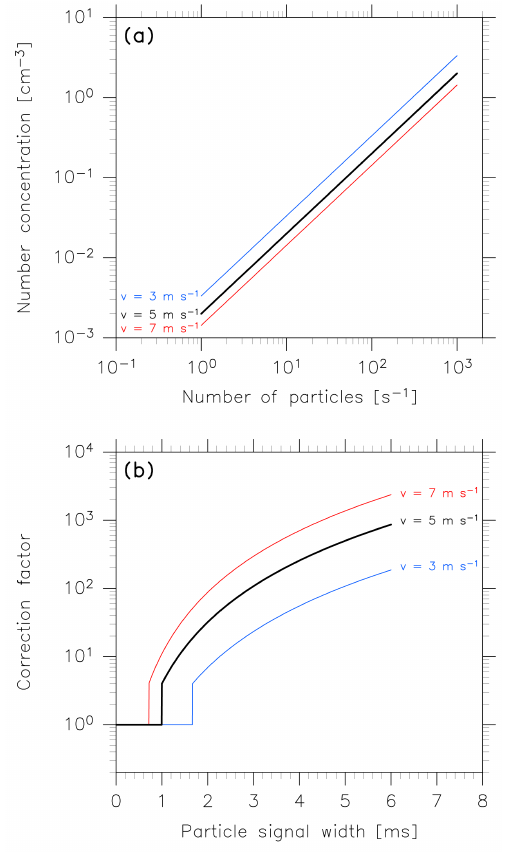
Figure C1. Dependence on the flow speed within the detection area ( v in ms − 1 ) for (a) the conversion from number of particles in s − 1 to number concentration in cm − 3 and (b) the correction factor for the number of particles ( N in s − 1 ) with respect to the particle signal width values in ms. Shown are for 5ms − 1 (black), 3ms − 1 (blue), and 7ms − 1